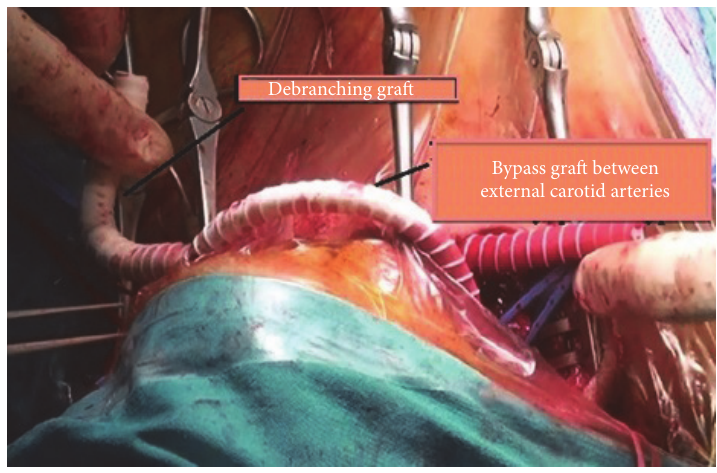
Figure 2: The bypass performed on the skin by 6 mm PTFE graft between both external carotid arteries is